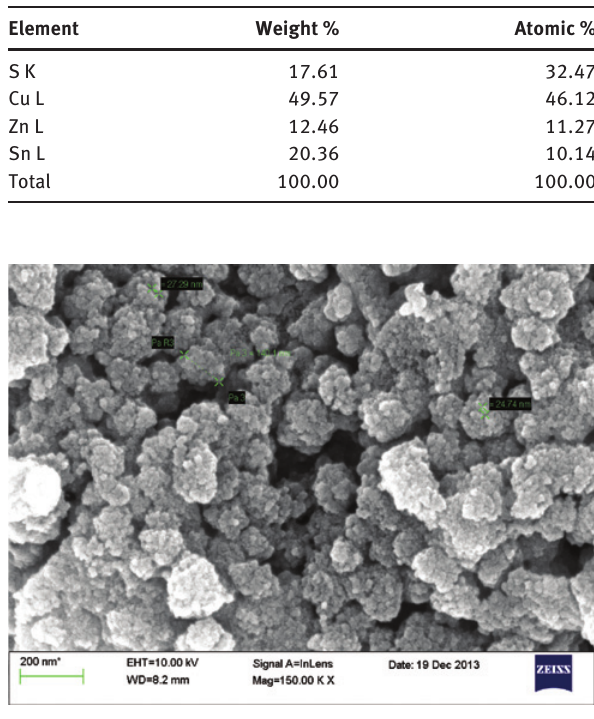
Figure 5: SEM of the as-synthesized sample showing the formation of CZTS nanoparticles.